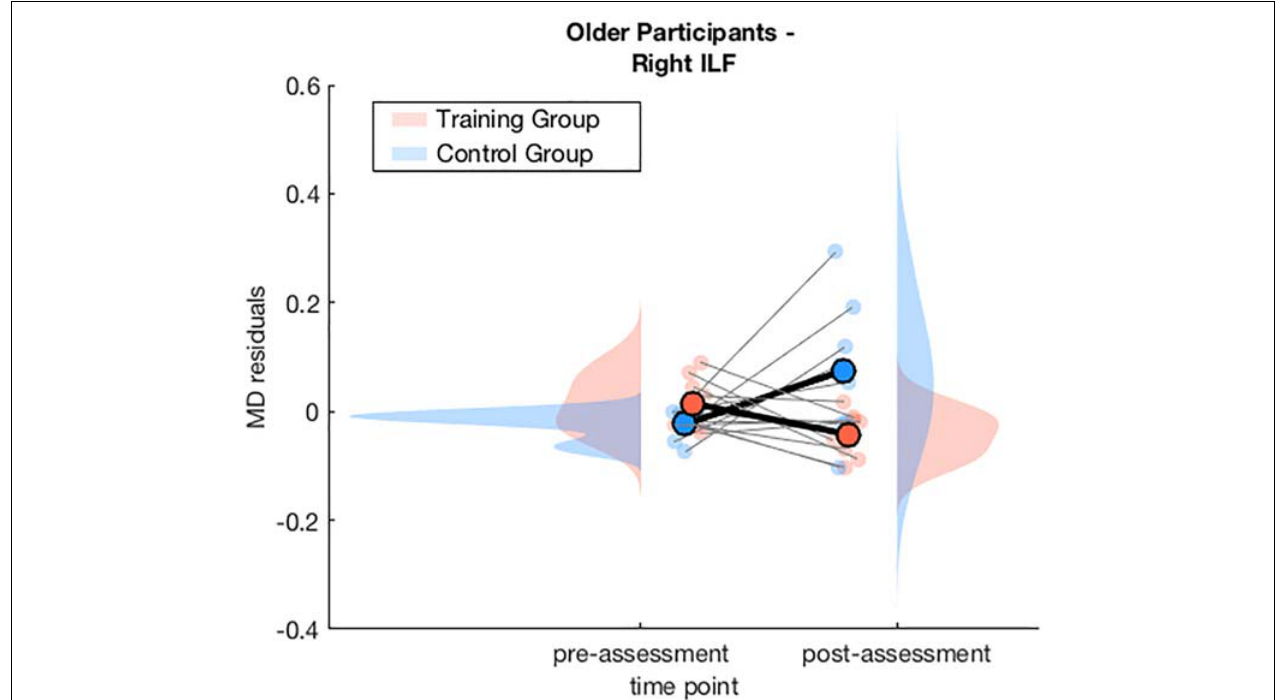
FIGURE 4 | Averaged MD residuals corrected for CNR, in-scanner head motion, and global MD for the right ILF of the WM group and AC group at pre-assessment and post-assessment of the generalized linear mixed-effects model including only older participants.